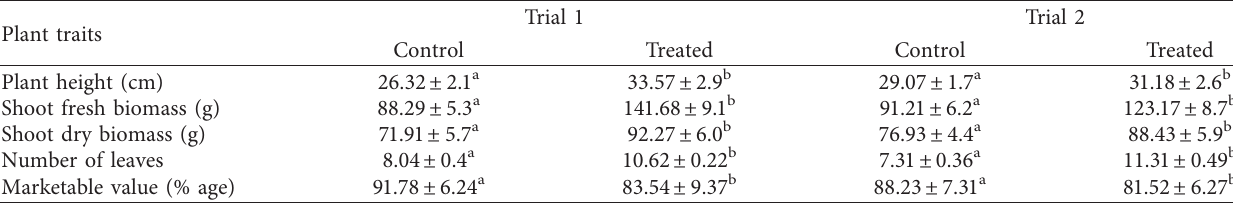
Figure 1: Effect of different concentration of leaf extracts of Glycyrrhiza uralensis on the relative growth rate of Chinese flowering cabbage. Vertical bars show standard error, whereas small letters show levels of significance among different treatments as governed by ANOVA and DNMRT at p � 0 . 05. Table 1: Changes in growth attributes of Brassica rapa under field conditions.